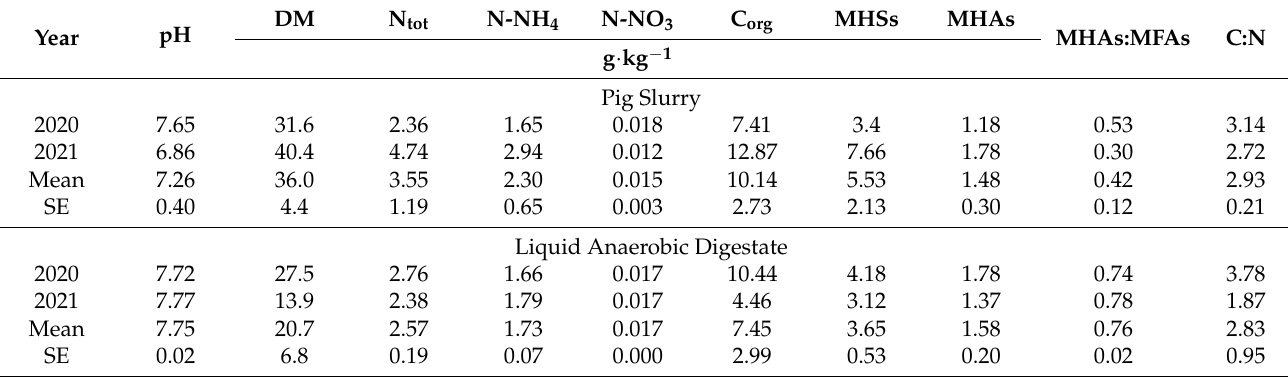
Table 1. Characteristic of liquid